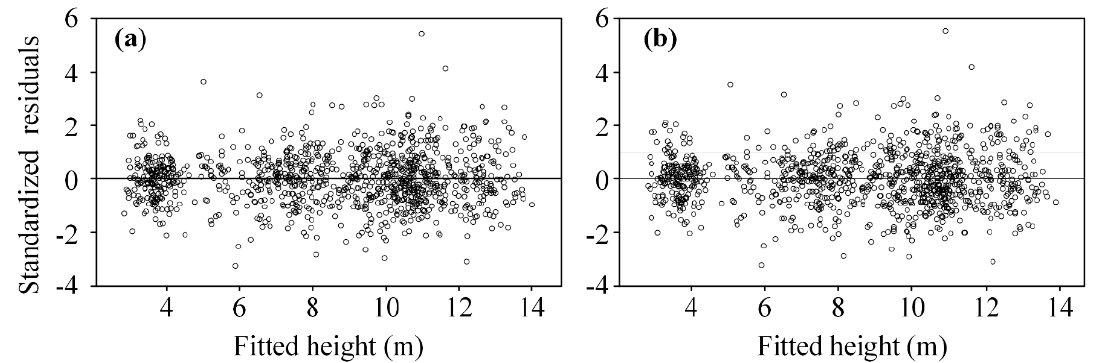
Figure 4. Distributions of standardized residuals of basic ( a , b ) generalized mixed-effects models.